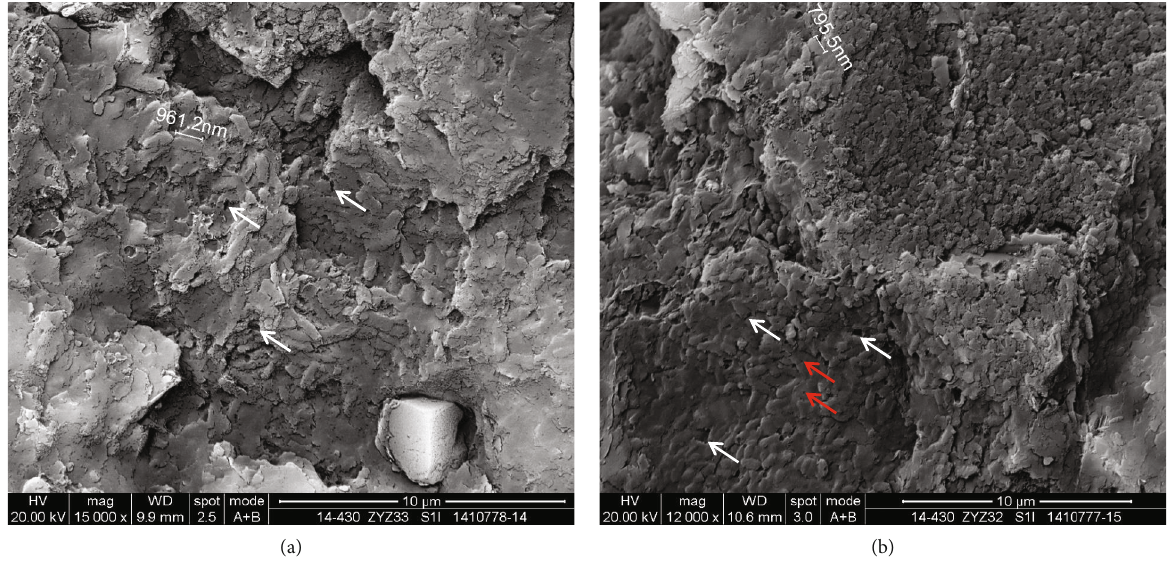
Figure 3: Unicellular algae in black shale. (a) Rhabditiform blue algae colonies and OM pores (white arrows) observed in the Longmaxi Formation black shale (well JY 2, 2543.84m (LM5 GZ), the TOC content is 3.8% and the R % is 2.55%). (b) Spherical nanoscale algae o colonies; small pores (red arrow) and large pores (white arrow). The OM pore is developed by the arrangement gaps of the algae (well JY 2, 2523.11m (LM6 GZ), the TOC content is 2.11% and the R % is o